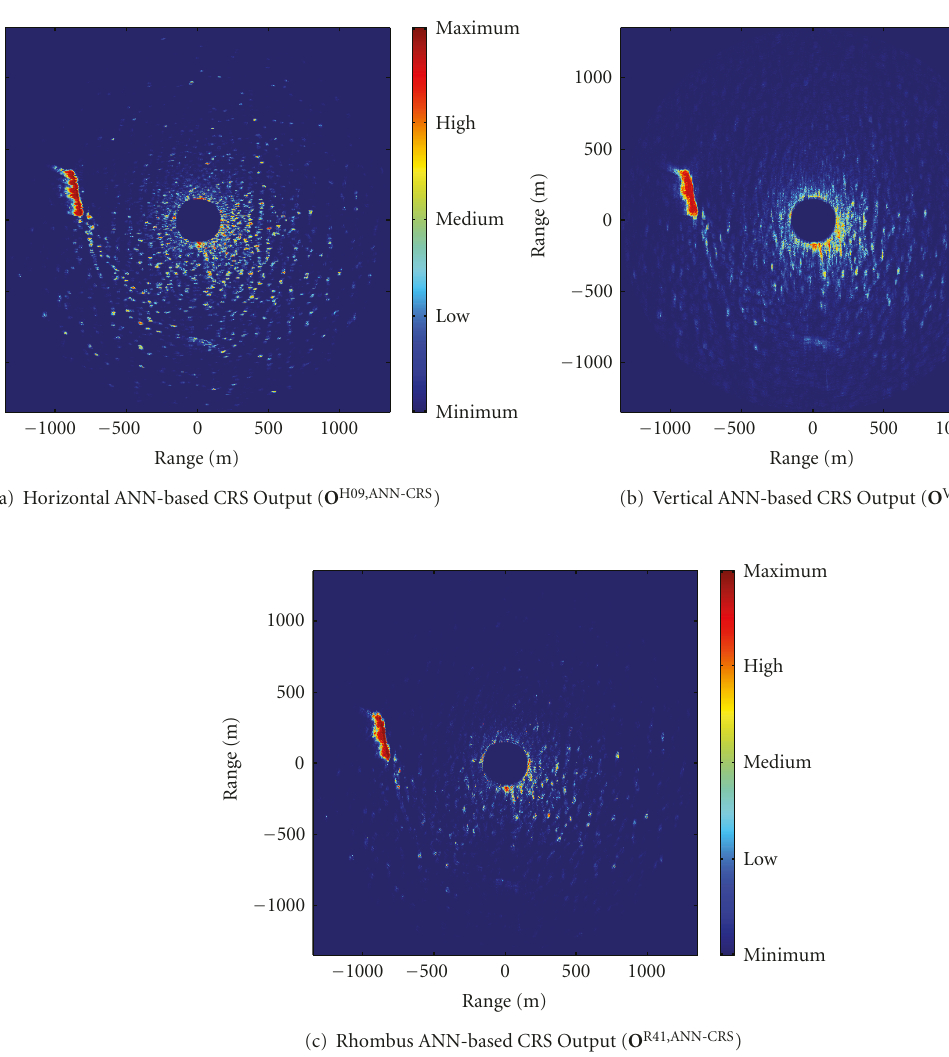
Figure 4: Radar Images Processed by the ANN-based Clutter Reduction System Using its Best H, V, and R Integration Modes.